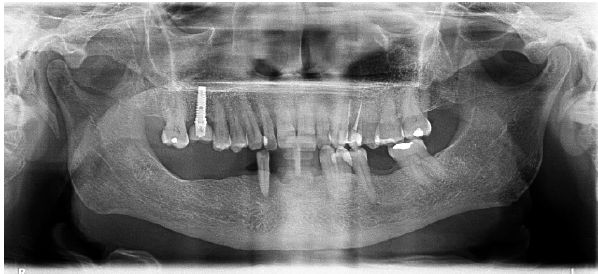
Figure 6. Orthopantomography four years since baseline after extraction of the lower central incisors and right first premolar.